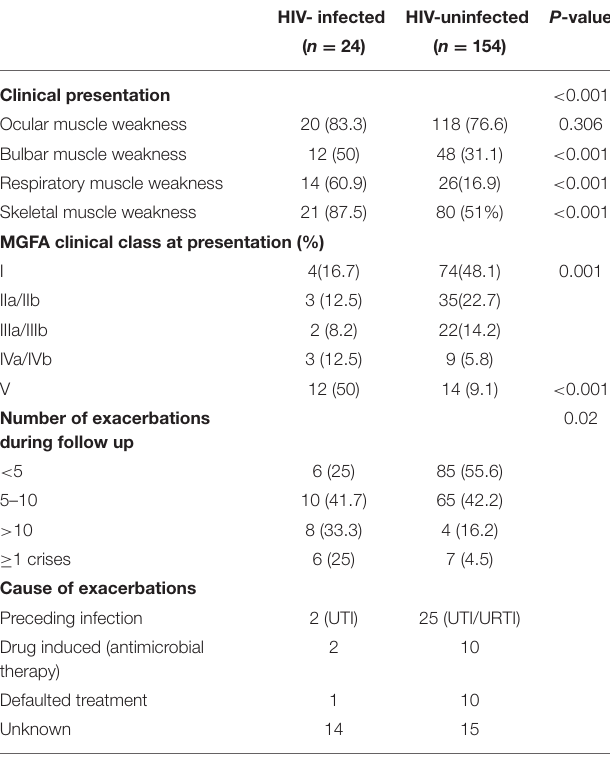
TABLE 1 | Demographic characteristics of HIV-infected and HIV-uninfected patients with MG.